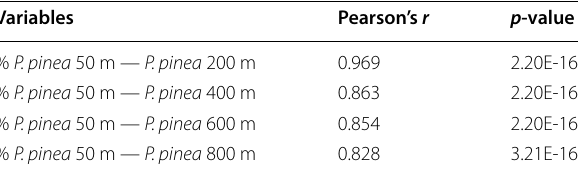
Table 3 Pearson’s correlation coefficients and the associated P ‑value of the t ‑test for the relationship between the % P. pinea in the 50 m buffer and the % P. pinea at larger buffer scales Variables